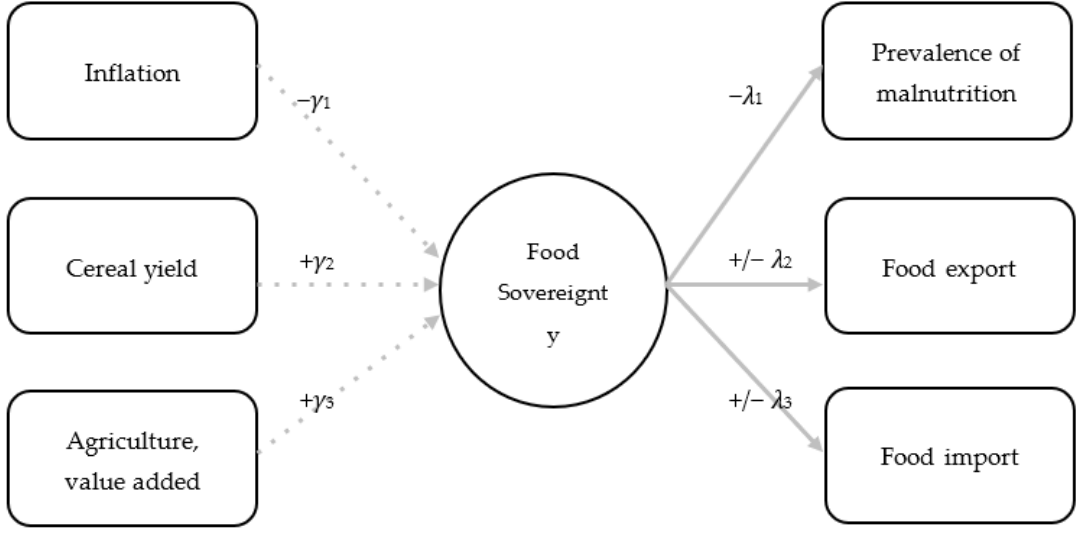
Figure 1. MIMIC path analysis food sovereignty.